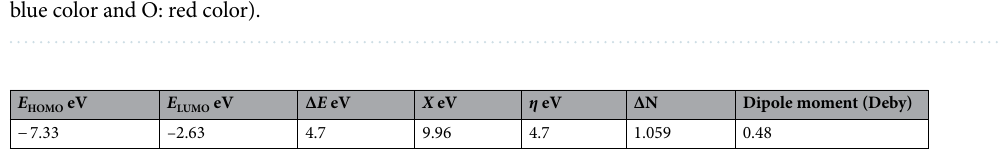
Figure 5. HOMO and LUMO of [DEMEMA][FSI] using B3LYP/6-31G (d,p). (H: white color; C: gray color; N: blue color and O: red color).